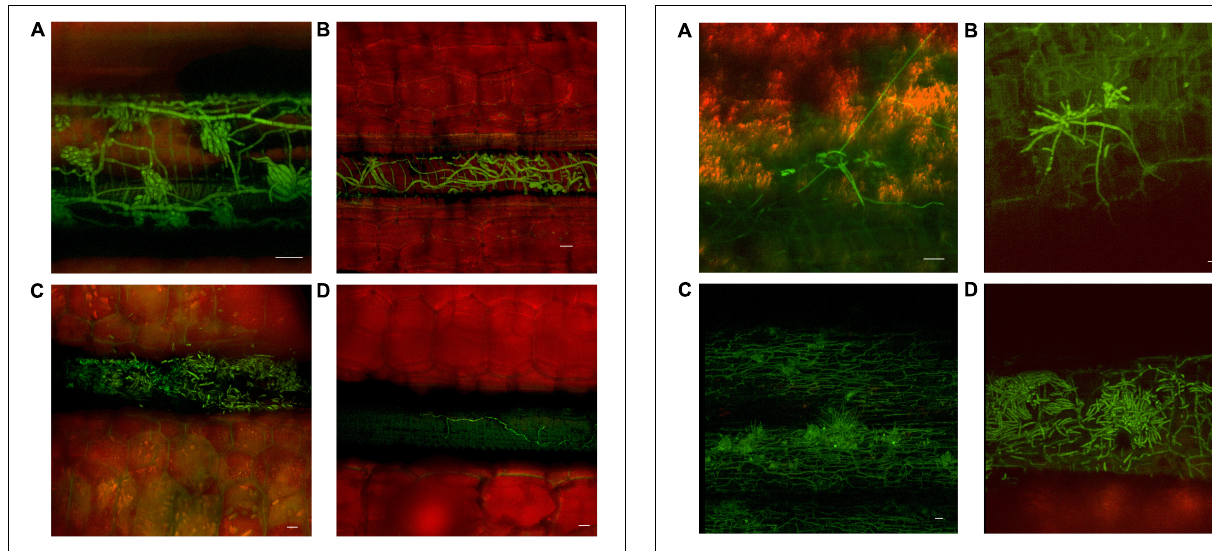
FIGURE 4 | Presence of fluorescing Fusarium oxysporum f.sp. cubense in the vascular system of the pseudostem of Lady Finger and Cavendish banana plants. (A) Lady Finger pseudostem 70 dpi at 10–15 cm above the rhizome showing microconidia formed on the end of monophialides. (B) Cavendish pseudostem 80 dpi at 10–15 cm above rhizome showing multiple strands of hyphae confined within a xylem vessel. (C) Lady Finger pseudostem 80 dpi at 10–15 cm above rhizome with germinated microconidia apparent within the xylem vessel. (D) Lady Finger pseudostem 40 dpi at 10–15 cm above the rhizome showing a single strand of hypha confined to a xylem vessel. Scale bars represent 20 µ m.